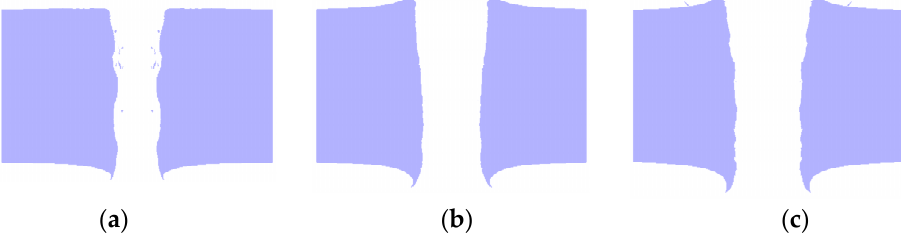
Figure 16. Numerical results of kinetic energy penetration for the three kinds of composite jets: ( a ) reactive material–Cu jet; ( b ) reactive material–Ti jet; ( c ) reactive material–Al jet.